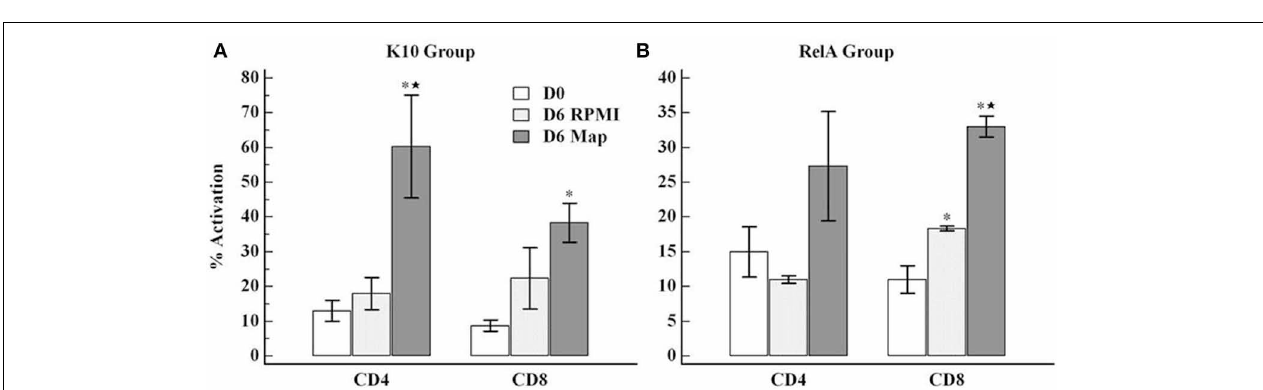
and stimulated proliferating cells (G2) and color coded to track activated cells. (B) Cells with no mAb. (C) Cells labeled with CD4 with no gate to show relative percent of resting and activated CD4 cells. (D) CD4 cells with a gate to select CD4 cells for analysis. (E) CD4 cells showing expression of CD45R0 only on memory cells. The activated cells (blue) also expressed CD25.